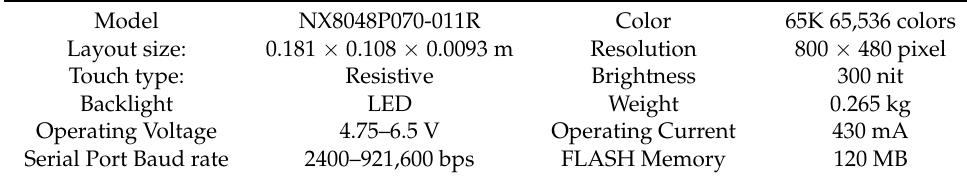
Table 4. HMI NEXTION ® 7” touchscreen features